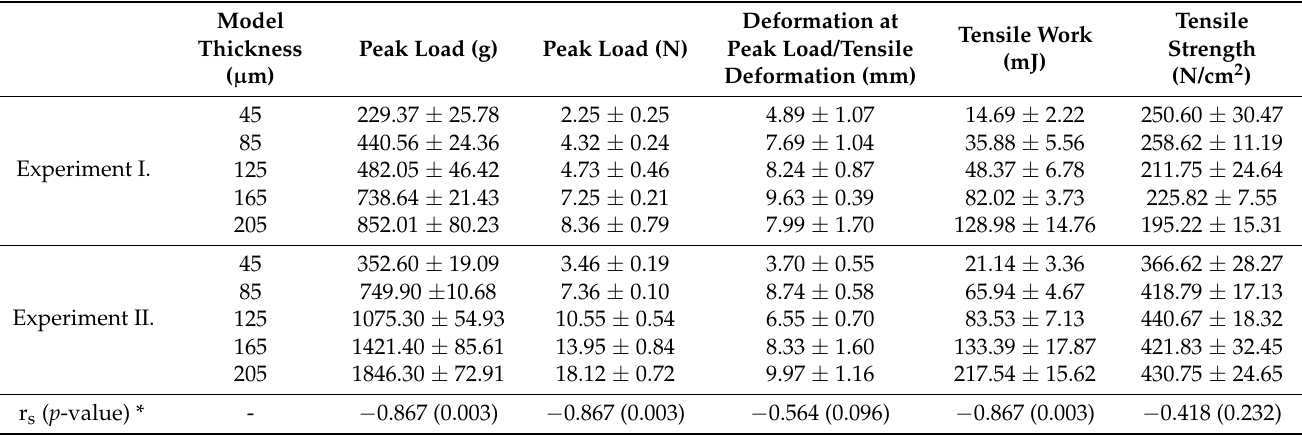
Table 6. Summary of the results from tensile